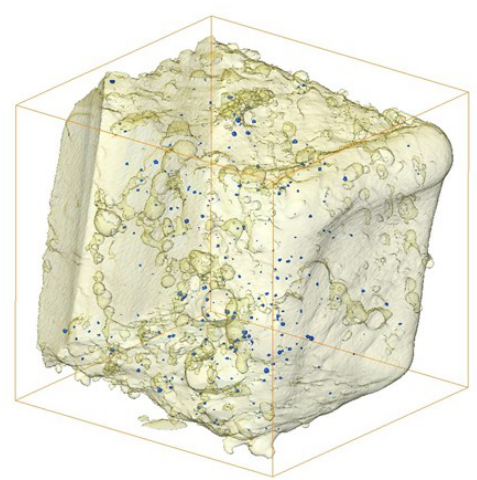
Fig. 4. Example image of porosity in additively manufactured gold (courtesy R. Loge, EPFL) at the sub-10µm scale obtained with the PSI neutron microscope detector (illustrating a far aim for compact sources)